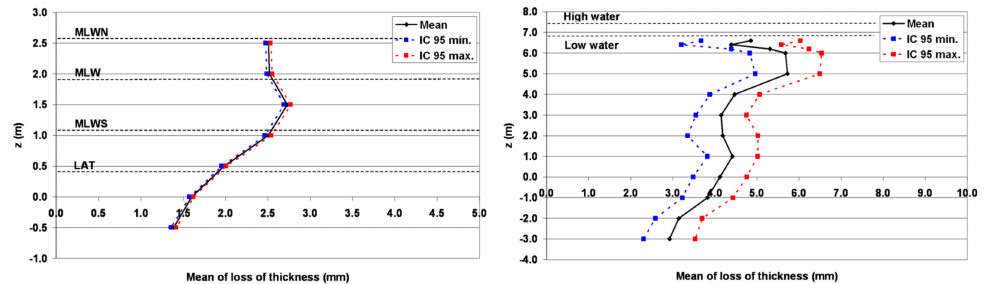
Figure 7. Mean of loss of thickness and 5–95% fractiles (IC) according to z—BO1 (left) and HA7d out-pans